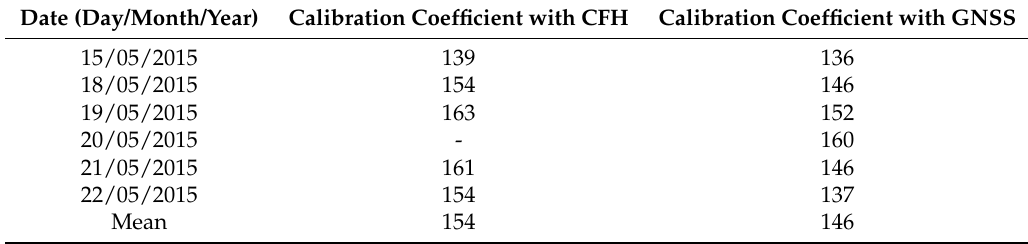
Table 2. Lidar1200’s nightly (and mean) coefficients calculated with CFH and GNSS IWV between 15 and 22 May